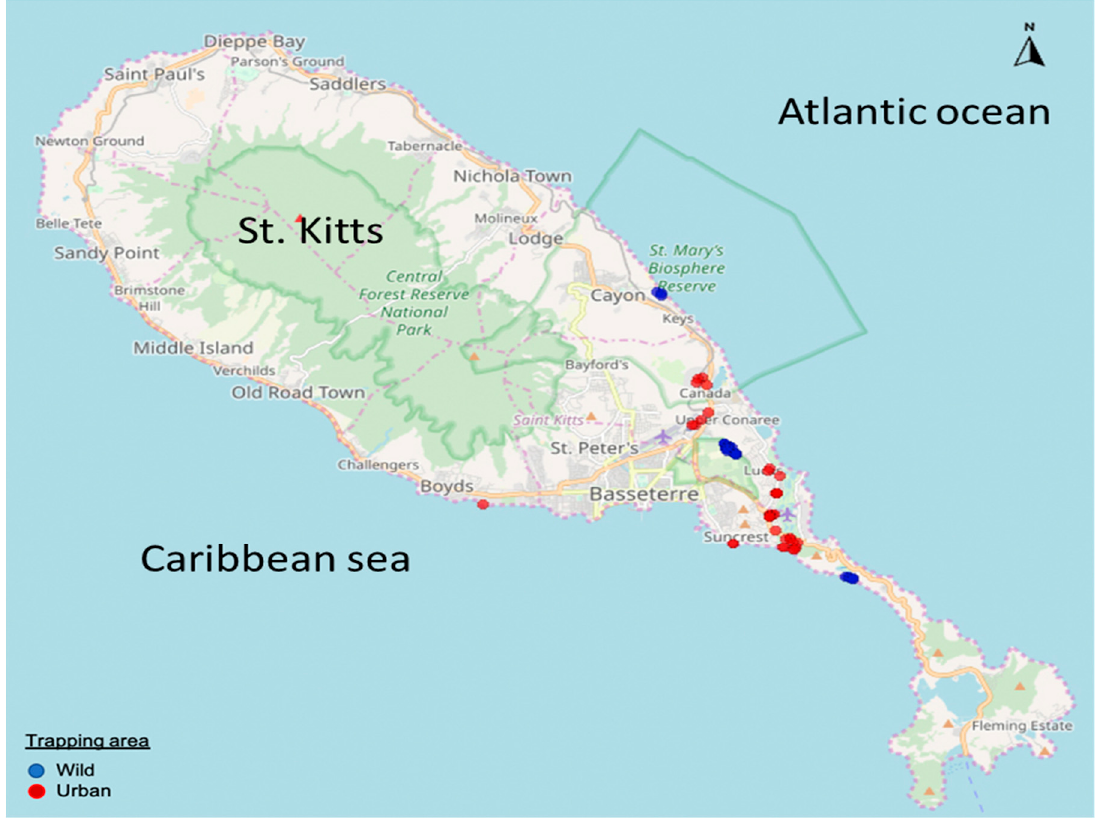
Figure 2. Map of island of St. Kitts showing the mongoose trapping sites. The trapping sites in wild and urban habitats are highlighted with blue and red, respectively.